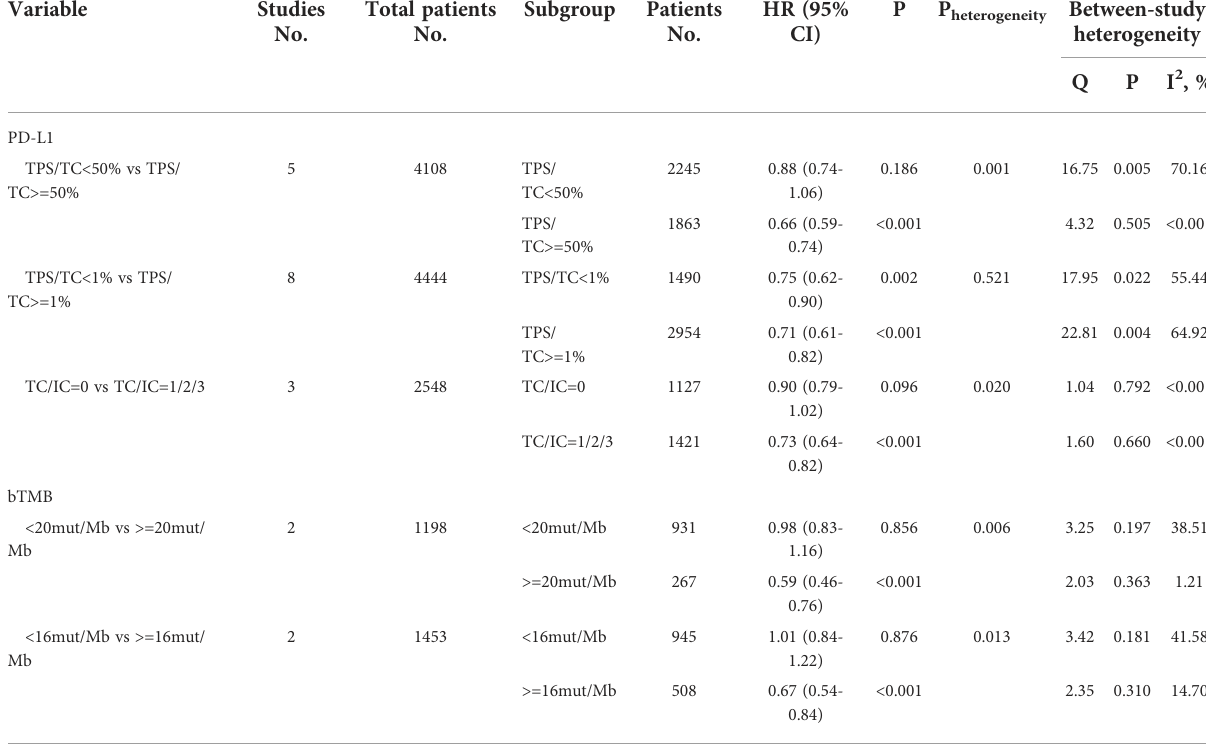
TABLE 3 Differences in ef fi cacy of IO vs control therapies by PD-L1 expression and bTMB. Variable Studies